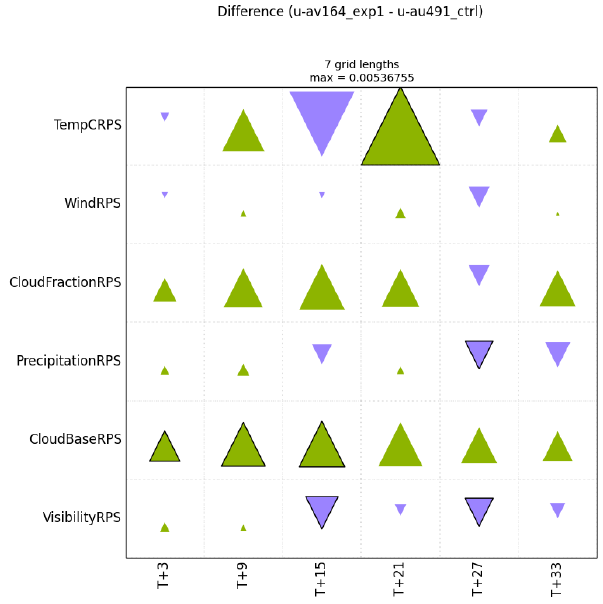
Figure 4. HiRA summary scorecard at 10.5km (seven grid lengths) spatial scale for UKV case studies run with improvements to the treatment of lying snow. HiRA uses synoptic observations (see Sect. 3).